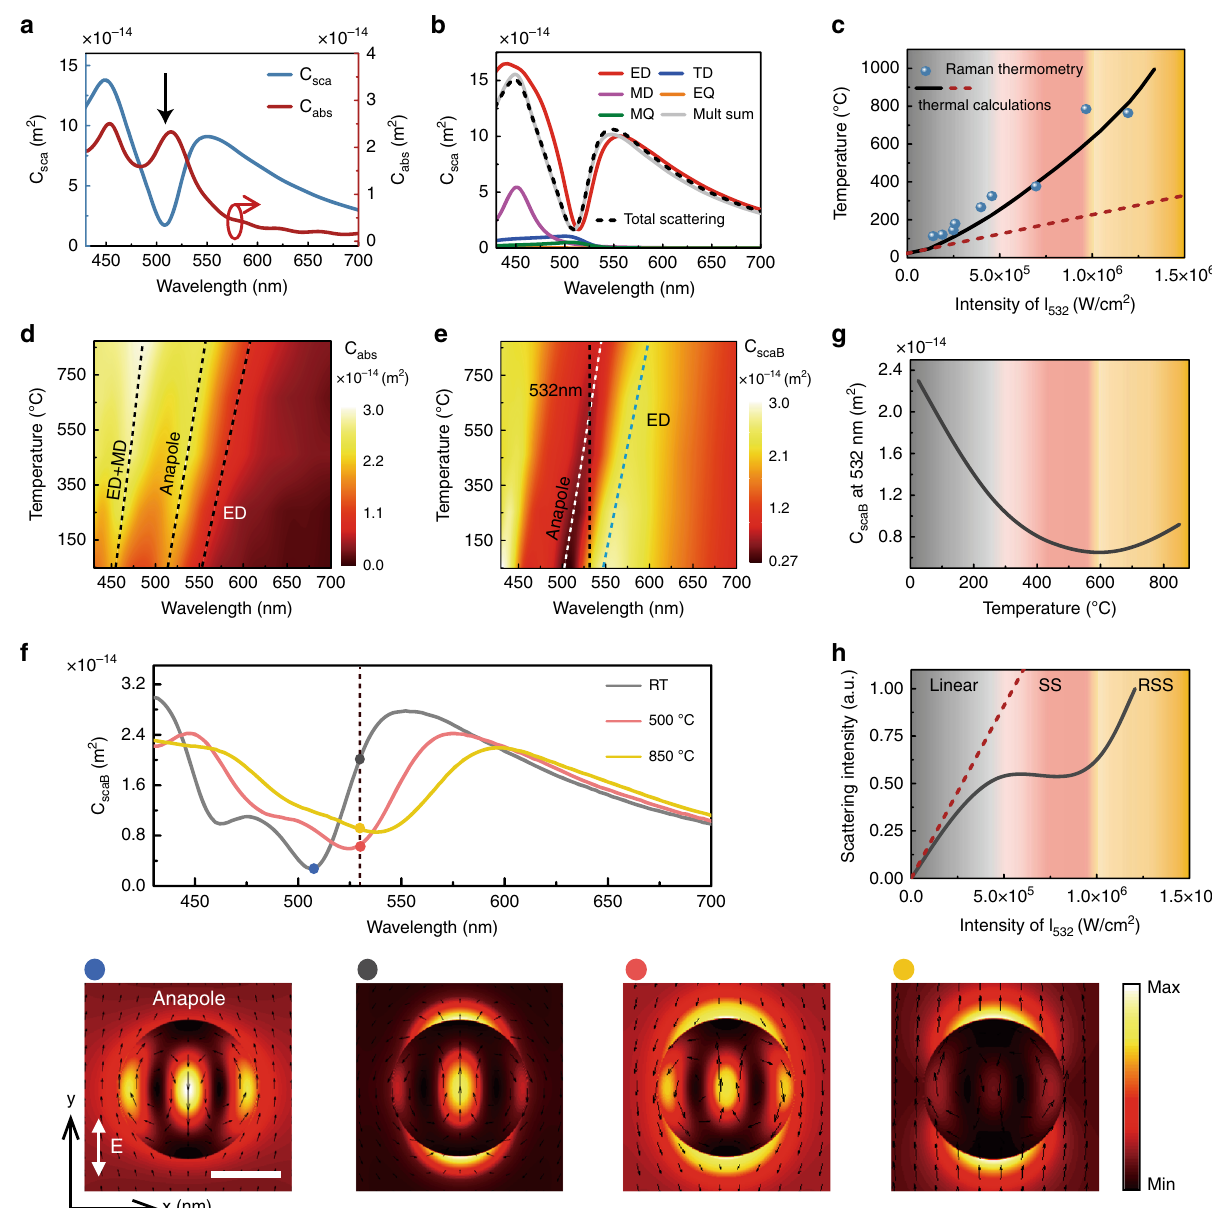
Fig. 3 Anapole-driven photothermal nonlinearity. a Simulations of optical scattering and absorption spectra of Si nanodisks. Gray arrow indicates the wavelength of the anapole mode featured with the scattering dip in the far- fi eld and boosted absorptions. b Multipolar decomposition of induced currents in Cartesian coordinates. Mult sum is the sum of the scattering contributions of considered multipoles. c Temperature rises in Si nanodisks as a function of the intensity of 532 nm excitation beam. Dots represent extracted temperatures through Raman nanothermometry based on the intensity ratio of anti- Stokes and Stokes signals. Solid lines denote thermal calculations based on iterative algorithms (see Method). The linear trend shown in red dashed lines represents calculated temperature without taking the change of complex indices into account. Simulation maps of the absorption cross section ( d ) and backward scattering cross section ( e ) of Si nanodisks as a result of temperature rises. The dashed lines in d indicate a series of absorption maxima associated with corresponding dominant modes. The white, blue, and black dashed lines in e denote the anapole state, electric dipole state, and excitation wavelength, respectively. f Backward scattering cross section at three representative temperatures (top panel) and corresponding near- fi eld distributions at the excitation wavelength of 532 nm (bottom panel). The white arrow in the fi eld distribution indicates the incident light linearly polarized in the y- direction. Scale bar, 100 nm. g Backward scattering cross section at the wavelength of 532 nm at elevated temperatures, showing that it undergoes fi rstly suppression and then recovery during the photothermal tuning. h Calculated photothermal nonlinear scattering as a function of irradiance